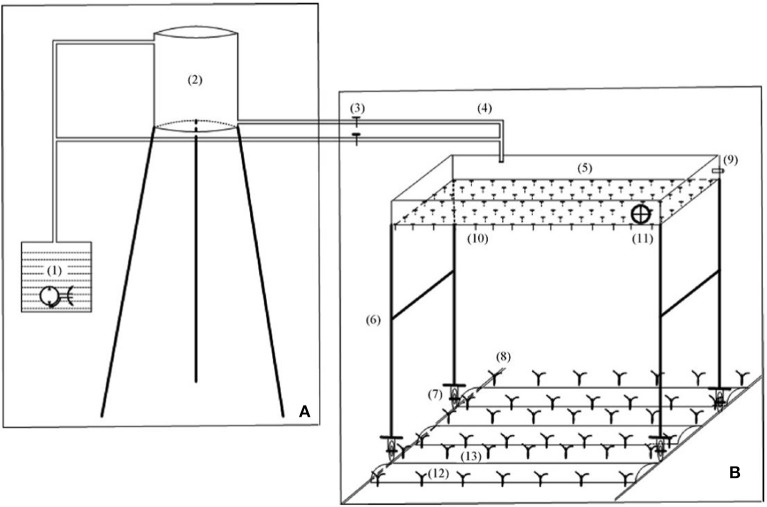
A schematic diagram showing simulator rainfall combined with ridge-furrow rainwater harvesting system under different deficit irrigation levels. (A) Water supply part; (B) rainfall simulation part; (1) water source with a pump; (2) water storage tank; (3) valves of the water pipes; (4) admitting pipe; (5) water tank made of iron sheet; (6) detachable support for the water tank; (7) pulley; (8) removable orbit; (9) surplus water drainage pipe; (10) syringe pinheads; (11) oscillating device; (12) ridges covered with plastic film; (13) planting furrows.